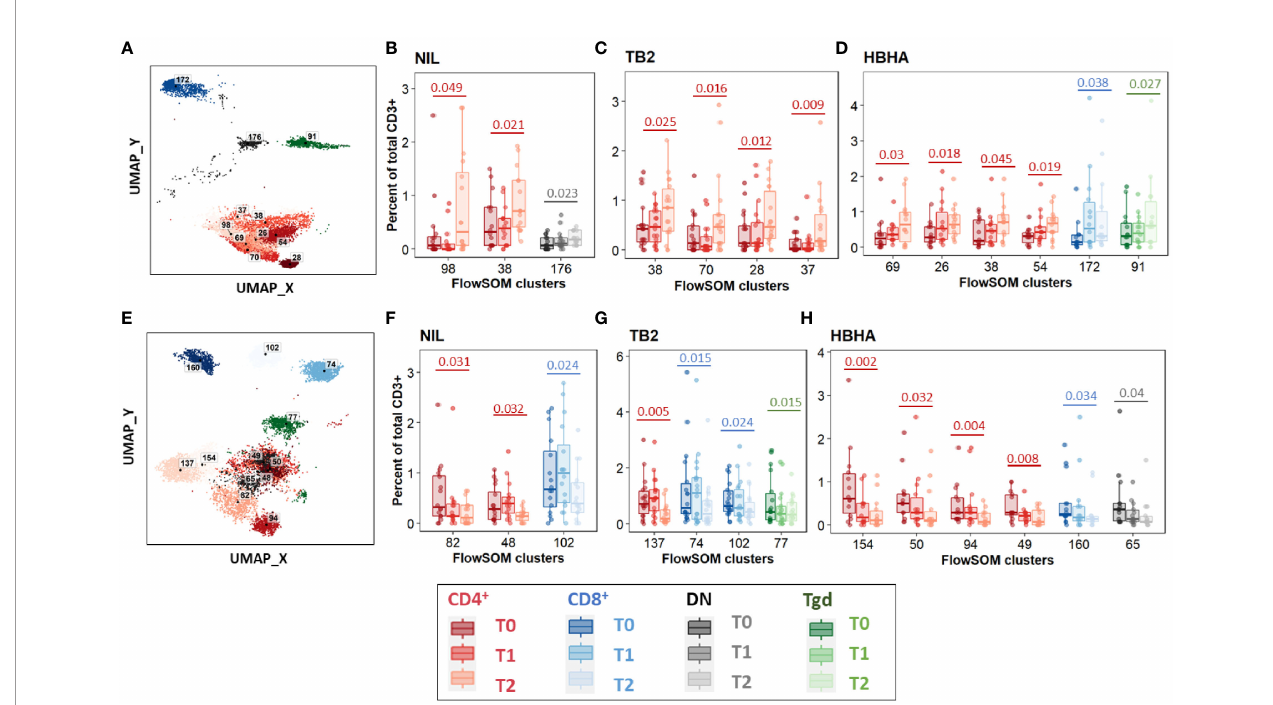
FIGURE 3 | Signi fi cant abundance changes in non-canonical T-cell subsets throughout TB treatment. FlowSOM cluster abundance was analyzed over time in unstimulated or Mtb -stimulated samples (TB2 or rmsHBHA). Only clusters within which signi fi cant abundance changes were detected were displayed. Number of matched data points per timepoint for all panels: NIL: n = 16. TB2: n = 18. rmsHBHA: n = 14. Data are represented as medians + interquartile range. (A – D) . Signi fi cantly increased clusters at treatment completion (T2) compared to treatment initiation (T0). Clusters within which a signi fi cant increase was detected between T0 and T2 were visualized on the reference UMAP shown in Figure 3 (A) . Cluster abundance quanti fi cation was was performed in unstimulated (B) , TB2-stimulated (C) or rmsHBHA-stimulated samples (D) . (E – H) Signi fi cantly decreased clusters at treatment completion (T2) compared to treatment initiation (T0). Mapping (E) and abundance quanti fi cation of clusters which increased between T0 and T2 in unstimulated (F) , TB2-stimulated (G) or rmsHBHA-stimulated samples (H) . DN, double negative CD4 - CD8 - ; Tgd, gamma delta T-cells. Statistical analysis: Friedman rank sum test and Wilcoxon-Nemenyi-Thompson post-hoc for pairwise comparisons between non-independent observations at T0, T1, and T2. Exact, unadjusted p-values are indicated on the fi gures. Benjamini-Hochberg corrections for multiple comparisons were performed as an indication and were not used for cluster selection for phenotype analyses in order to minimize type II errors. Adjusted p-values did not reach signi fi cance. All adjusted p-values and complete test statistics are available in Supplementary Table 5